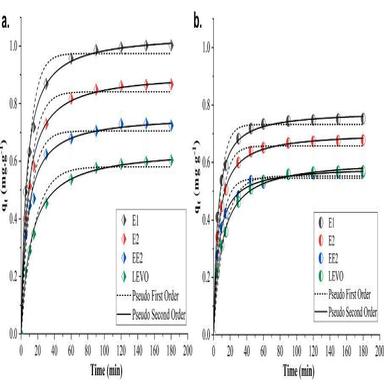
Kinetic models for simultaneous hormones removal from water by TiO2-AC15%-541 at pH 2.64 (a), and pH 5.9 (b).